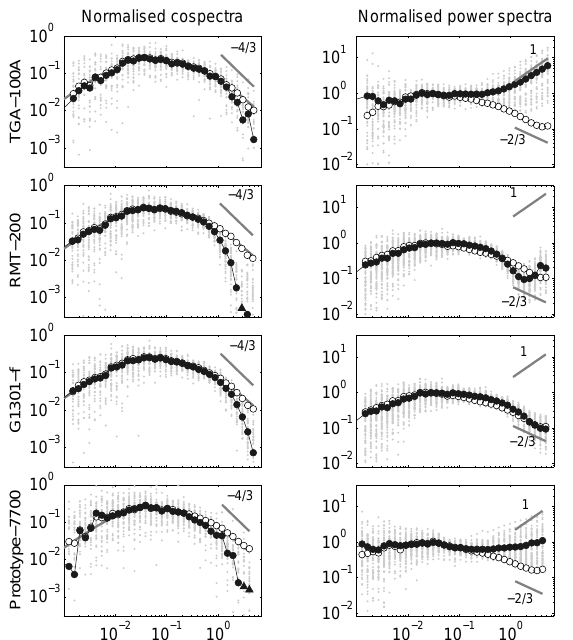
Fig. 3. Frequency weighted, normalized cospectra and power spectra plotted against normalized frequency n . The ensemble averaged methane and temperature cospectra and power spectra are shown with black and white dots, respectively. Black trian- gles represent negative points of the ensemble averaged methane cospectrum. Small grey dots represent individual methane data from which the mean cospectra and power spectra are calculated from. Straight line in the figures on the left indicates a slope of − 4 / 3 (Kaimal et al., 1972). Lower and upper straight lines in the figures on the right correspond to ideal slope of − 2 / 3 and 1, respectively. Slope of 1 is a sign of white noise (Kaimal and Finnigan, 1994). Cospectra were normalized with corresponding covariance and power spectra were normalized with variance values calculated be- tween frequencies 0.005 Hz and 0.1 Hz . Spectral data was binned into 35 logarithmi- cally evenly spaced bins before plotting. For Prototype-7700 data was selected from period 17 April–17 May, when methane flux was on average 0.5 mgm − 2 h − 1 , while for other gas analyzers the data was selected from period 9–29 June, when methane flux was on average 3.4 mgm − 2 h − 1 .